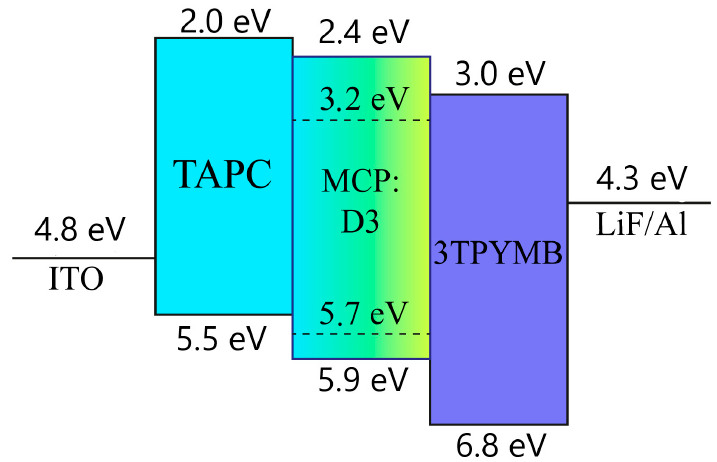
Figure 6. Energy band diagram of OLED structure ITO/TAPC (60 nm)/ D3 (10 wt%): mCP (25 nm)/TPYMB(30 nm)/LiF (1 nm)/Al.